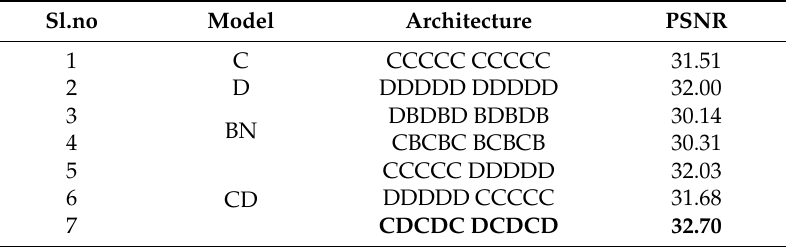
Table 1. Network